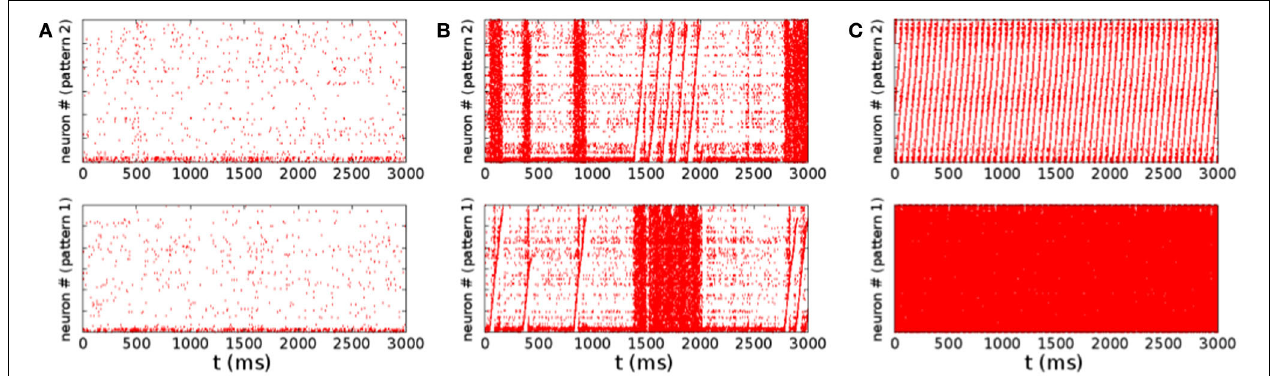
Frontiers in Systems